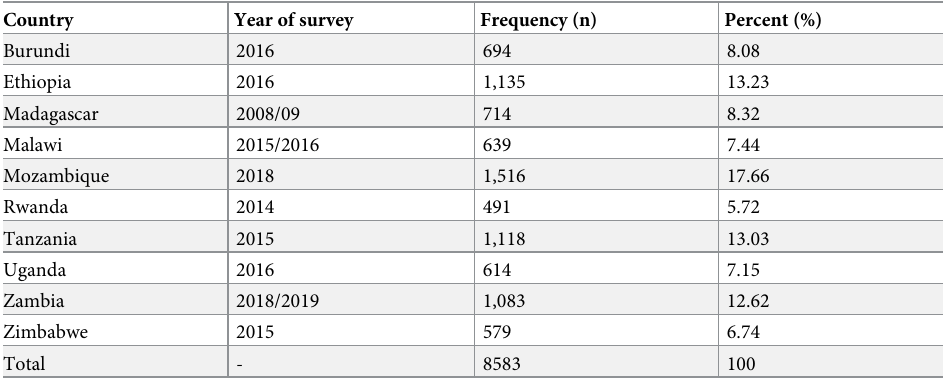
Table 1. The study participants by country and respective year of the survey.